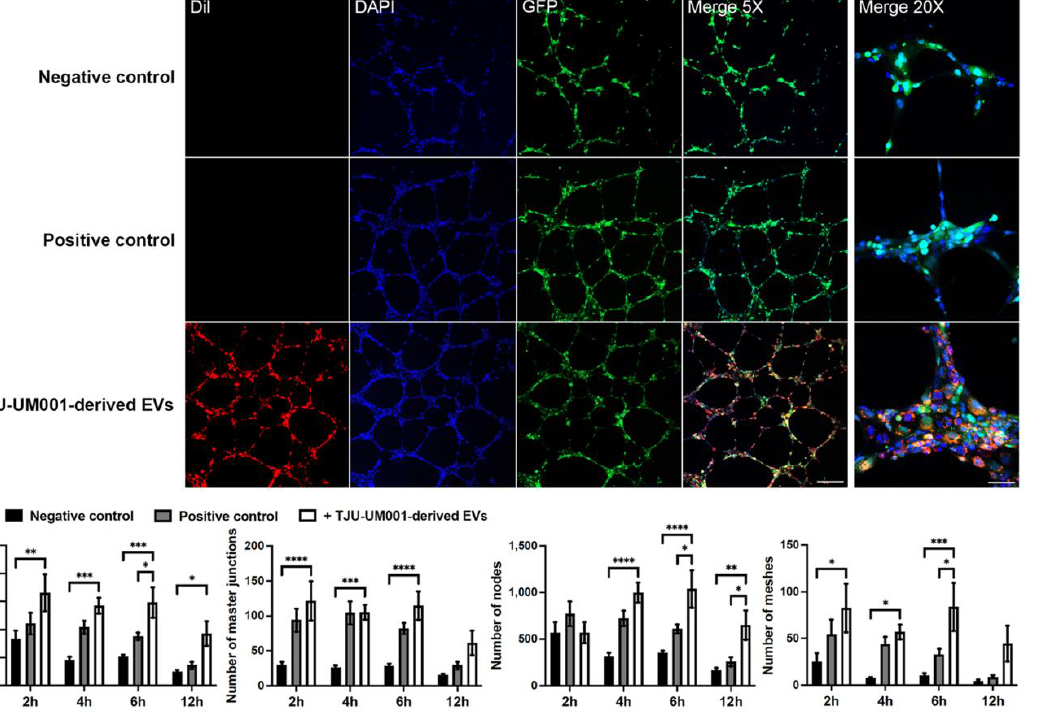
Figure 8. UM-derived EVs increased the formation of capillary-like tubes by endothelial cells. ( A ) Untreated GFP-HUVECs (green) were cultured for 12 h on Matrigel ® with medium without VEGF (negative control; top panels) or medium supplemented with VEGF (positive control; middle panels). Images are from the 6 h time point. Nuclei were counterstained with DAPI (blue). Scale bars: Merge 5X, 200 µm; Merge 20X, 50 µm. ( A ) Large EVs isolated from metastatic UM cell line TJU-UM001 were labeled with DiI (red) and added to GFP-HUVECs (green) for 24 h before their seeding on Matrigel ® for 6 h (bottom panels). ( B ) The number of junctions, master junctions, nodes, and meshes were quantified in function of time (hours) for each condition. Error bars indicate SEM ( n = 3); * p < 0.05, ** p < 0.01, *** p < 0.001, and **** p < 0.0001 (two-way ANOVA with Sidak’s multiple comparisons